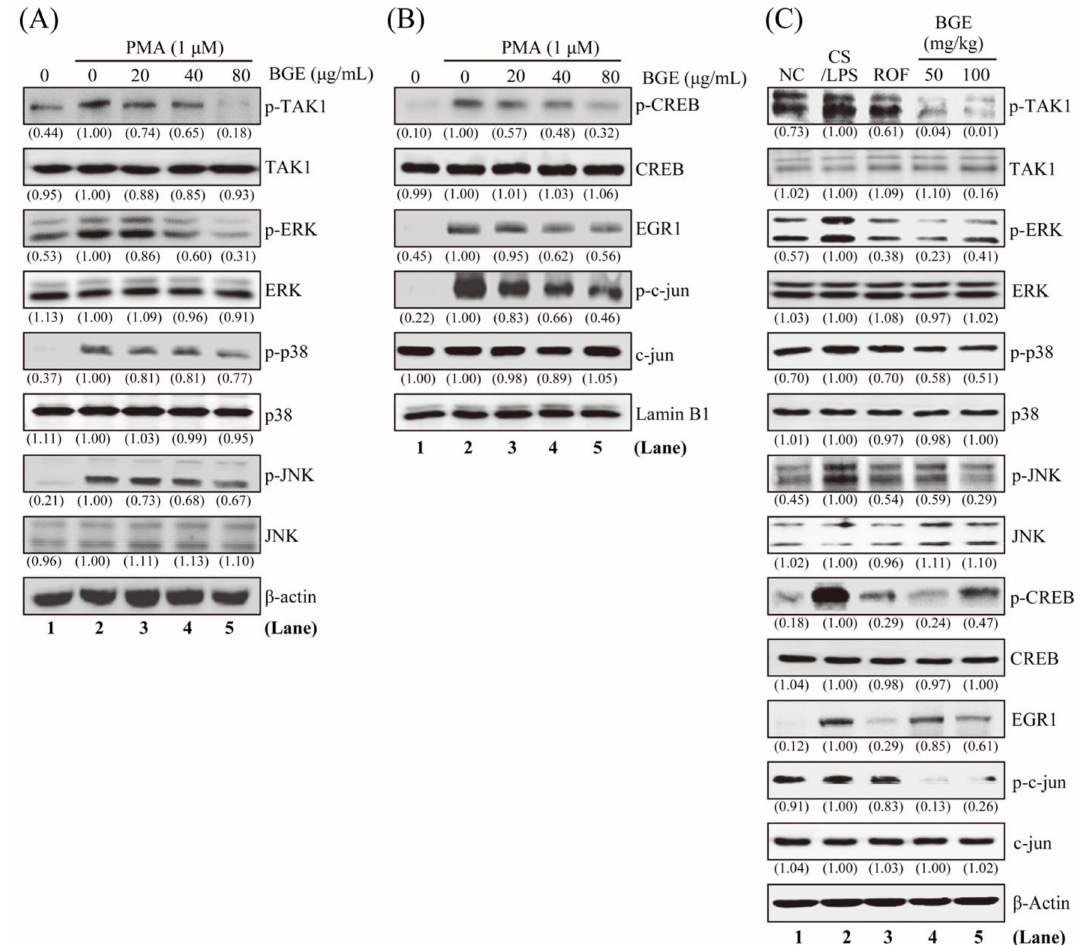
Figure 4. The effects of the BGE on TAK1 and MAPK signaling pathways in NCI-H292 cells and lung tissues of the CS/LPS-treated mice model. ( A , B ) Cells were pre-treated with indicated concentrations of BGE for 2 h, and subsequently treated with 1 µ M PMA for 30 min. Total cell lysates ( A ) or nuclear extracts ( B ) were assayed by Western blotting using antibodies against p-TAK1, TAK1, p-ERK, ERK, p-JNK, JNK, p-p38, p38, p-CREB, CREB, EGR1, p-c-jun, and c-jun. β -actin or Lamin B1 were used as a loading control for the total lysates and nuclear extracts, respectively. The numbers underneath the bands indicate the relative band intensity to the PMA-treated control. ( C ) Western blot analysis was performed to detect the activation of TAK1 and its downstream molecules in the lung tissues of CS/LPS-treated mice using antibodies against p-TAK1, p-ERK, p-JNK, p-p38, p-CREB, EGR1, and p-c-jun. β -actin was used as a loading control for the total lysates of lung tissues. The lane numbers are indicated below the Western blot image. The numbers underneath the bands indicate the relative band intensity to control which were treated with CS/LPS alone. Western blotting was independently performed twice. NC: normal control mice; CS/LPS: CS/LPS-exposed mice; ROF: 5 mg/kg ROF-treated CS/LPS mice; BGE 25: 25 mg/kg BGE-treated CS/LPS mice; BGE 50: 50 mg/kg BGE-treated CS/LPS mice; and BGE 100: 100 mg/kg BGE-treated CS/LPS mice